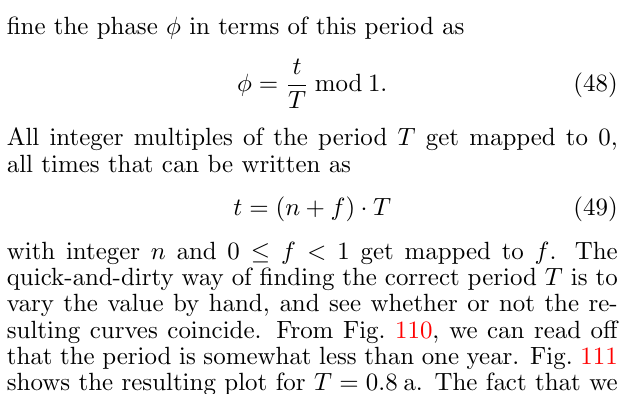
fine the phase φ in terms of this period as